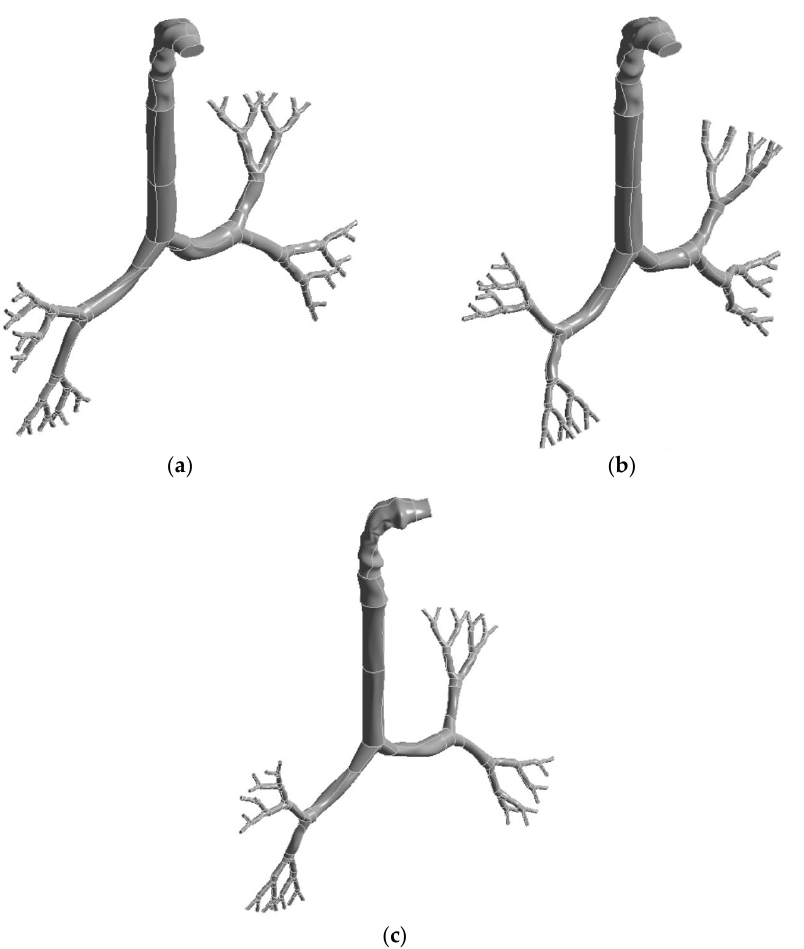
Figure 1. Construction of models from a CT-based mouth-throat model and Weibel’s model of a large bronchial airway: ( a ) 50-year-old lung, ( b ) 60-year-old lung, and ( c ) 70-year-old